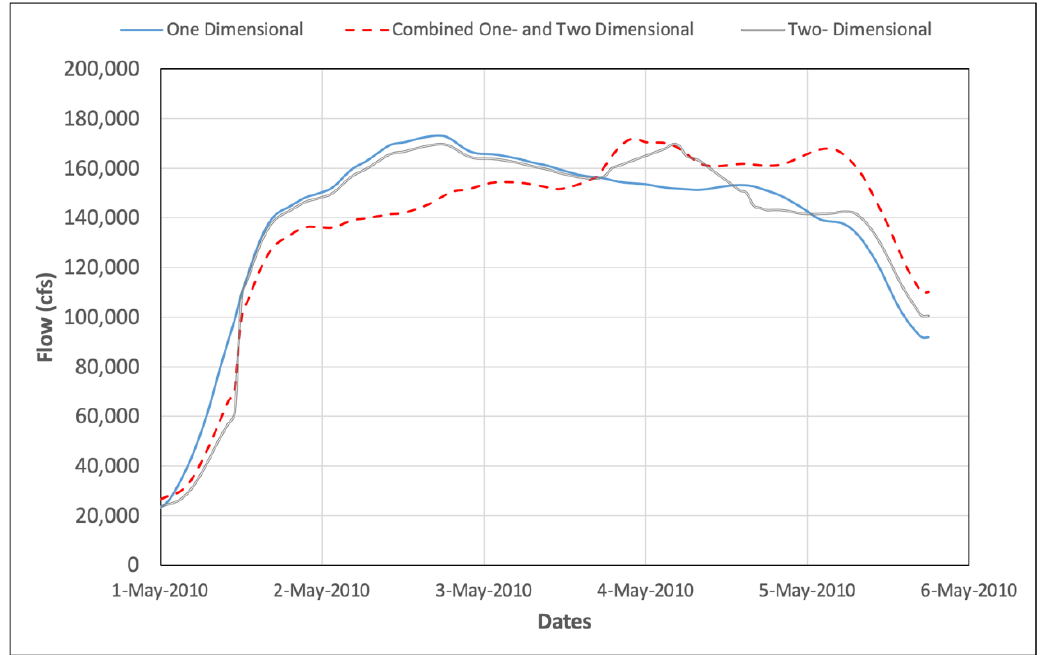
Figure 12. Optimized discharges at Nashville for the May 2010 flood event for three scenarios of unsteady flow modeling.